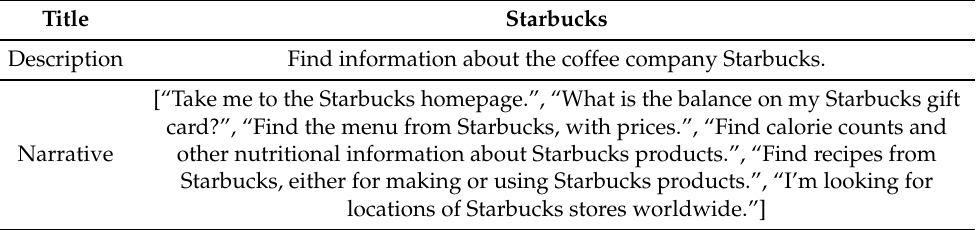
Table 3. Example of query text in ClueWeb09 (Topic